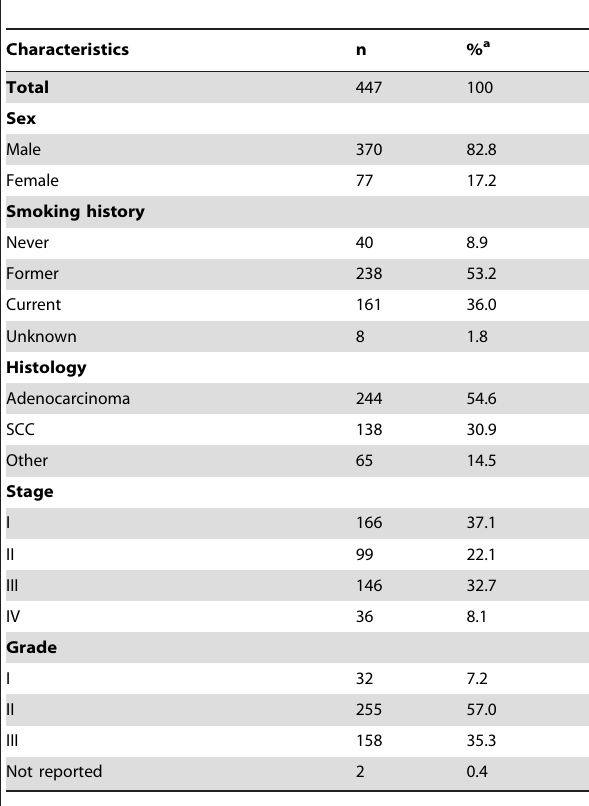
Table 1. Patient